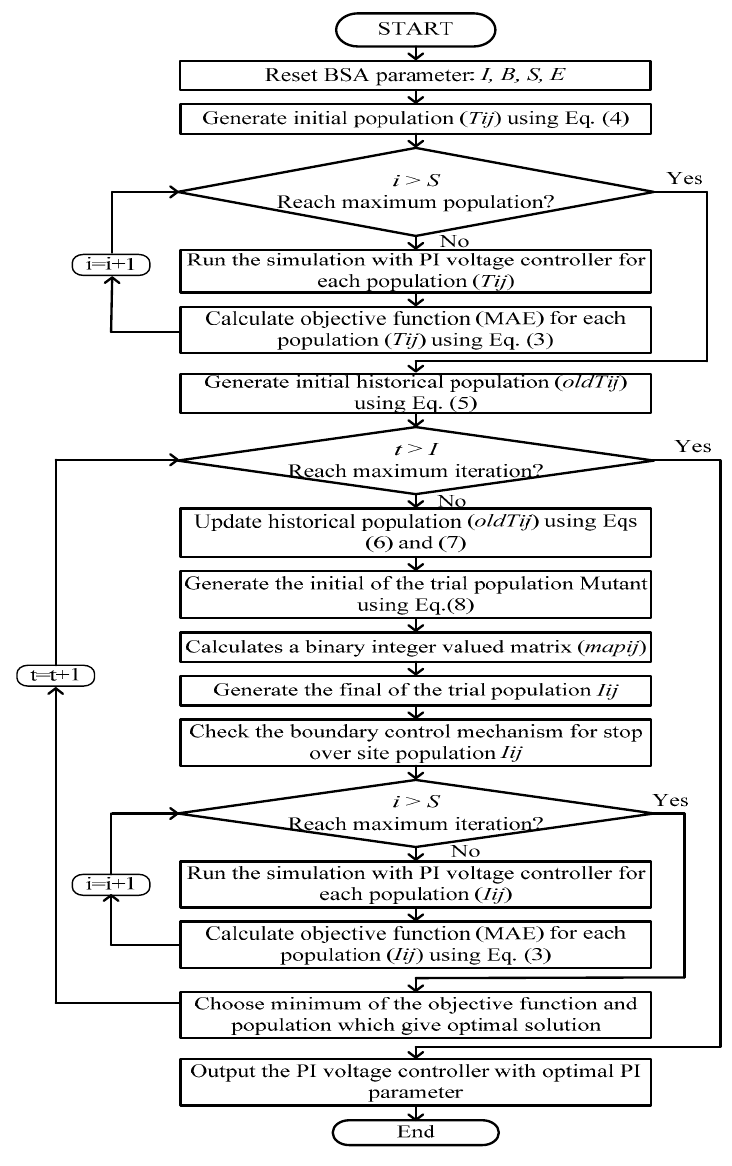
Figure 4. Proposed BSA-based optimum proportional-integral (PI) voltage controller design procedure.